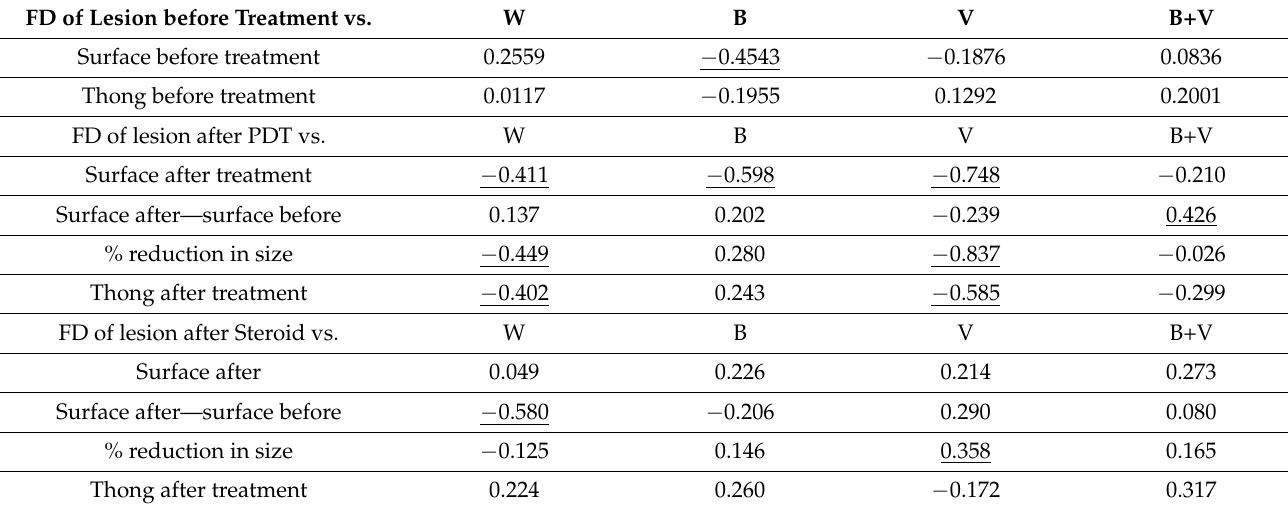
Table 6. The values of the Pearson correlation coefficient (r) between the value of fractal dimension (FD) calculated in different wavelengths and the size of the lesion before the treatment, Thongprasomn’s scale, the surface area of the lesion after treatment, the difference between its surface area after and before the treatment, and the percentage of lesion reduction (Thong—Thongprasom scale), underlined—|r| > 0.4.